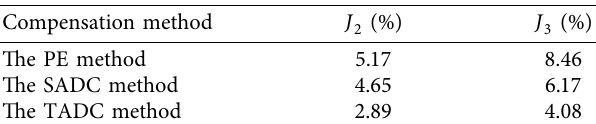
Figure 14: Desired-measured displacement plots with seismic excitation. (a) The PE method. (b) The SADC method. (c) The TADC method. Table 3: Evaluation indexes of RTHS with seismic excitation.